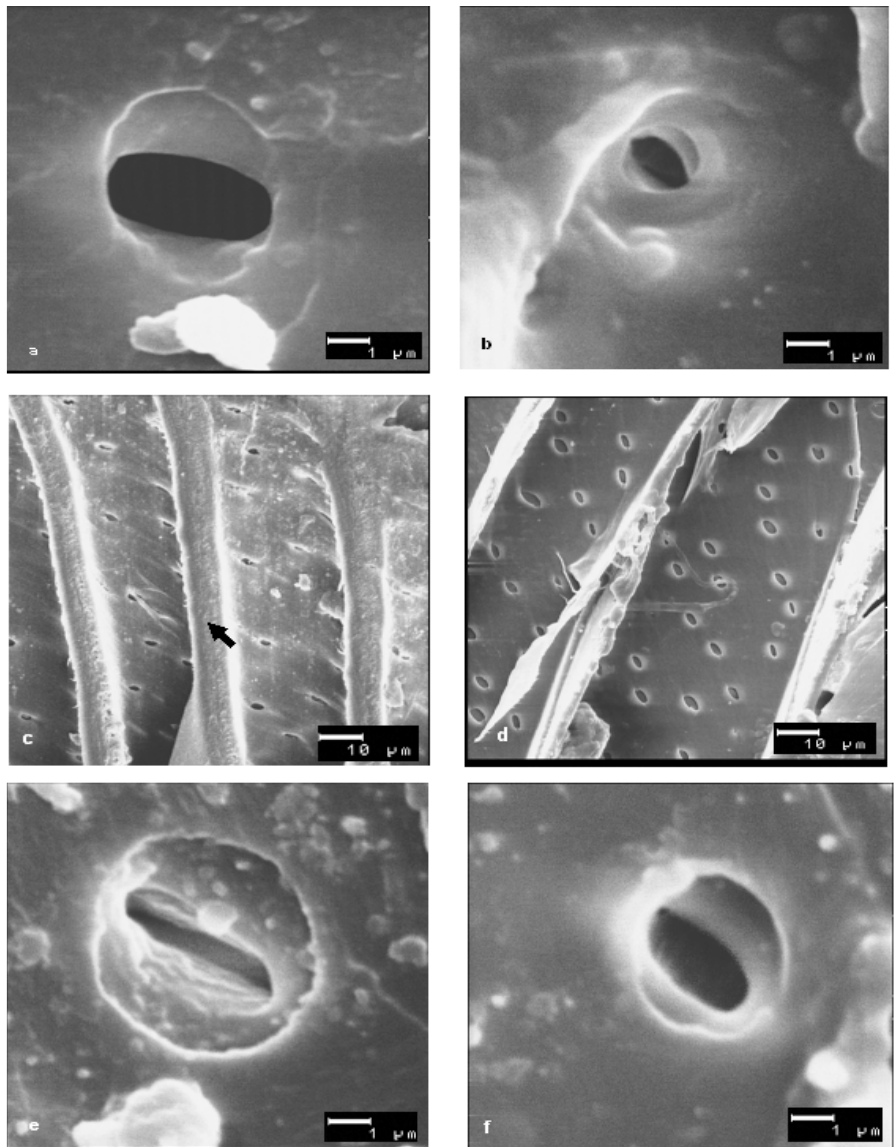
Fig. 5. SEM micrographs of cross-field pits in compression and opposite wood of Picea abies ; a: A cupressoid cross-field pit in op- posite wood; b: A small taxodioid cross-filed pit in compression wood; c: Tracheid pit apertures in compression wood; d: Larger apertures of tracheid pits in opposite wood; e: A piceoid cross-field pit in compression wood; f: A cupressoid cross-field pit in compression